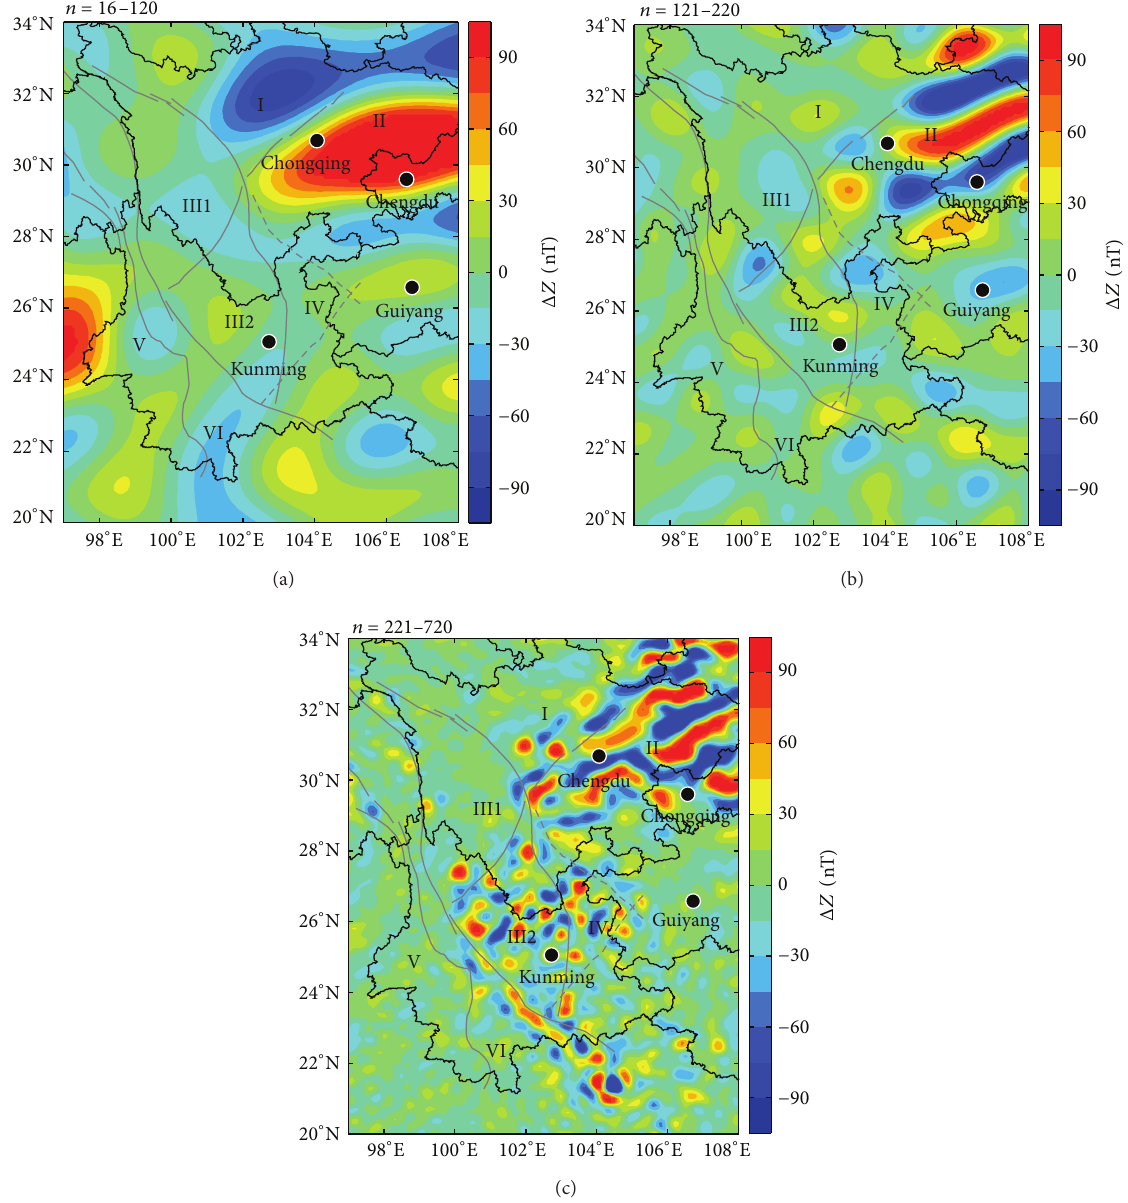
Figure 5: The magnetic anomaly at different wavelength bands: (a) 𝑛 = 16 ∼ 120; (b) 𝑛 = 121 ∼ 220; and (c) 𝑛 = 221 ∼ 720 in Sichuan-Yunnan